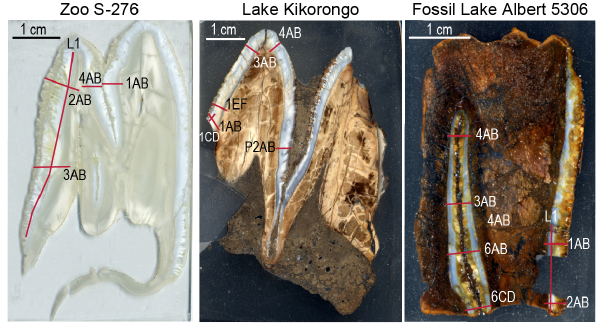
Fig. 1. Thin sections of selected samples of molar Hippopotamid teeth ranging in age from recent (S276, molar M3), 10ka (Lake Kikorongo, molar M3) to 2.3Ma (5306, molar frag.) indicate vari- able degrees of diagenetic overprint. Profiles of major and minor element analyses are